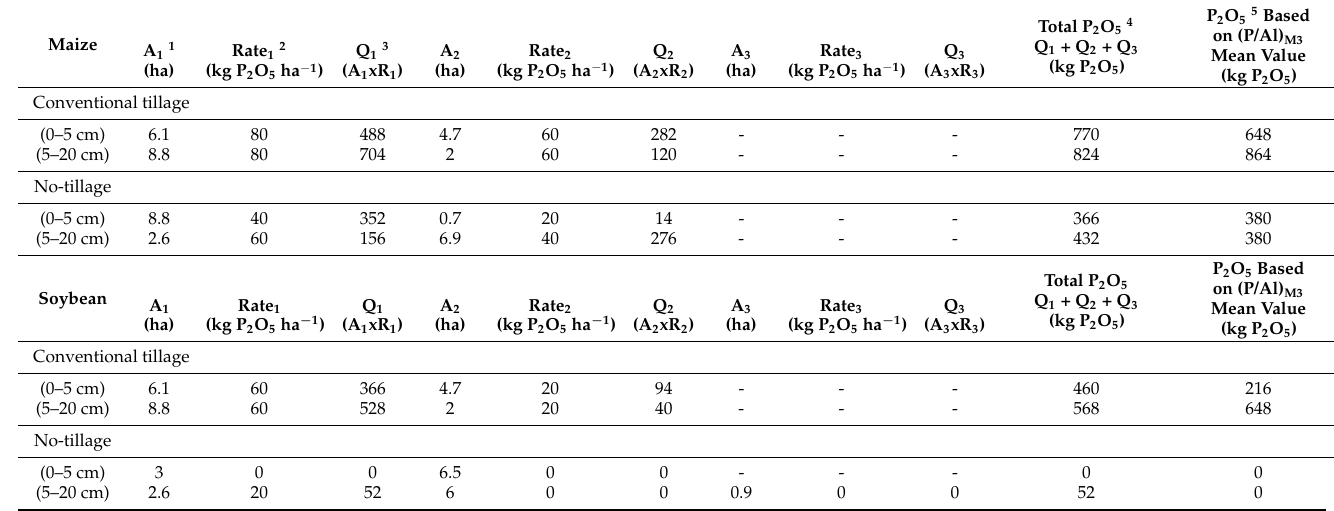
1 A: specific area (ha) from each specific management zone measured using ArcGIS. 2 Rate: P specific recommen- dation (kg P 2 O 5 ha − 1 ) corresponding to each kriged value of (P/Al) M3 from the specific area. 3 Q = A × R: this value represents the accurate total P recommendation (kg P 2 O 5 ) applied in each delimited area (A), based on